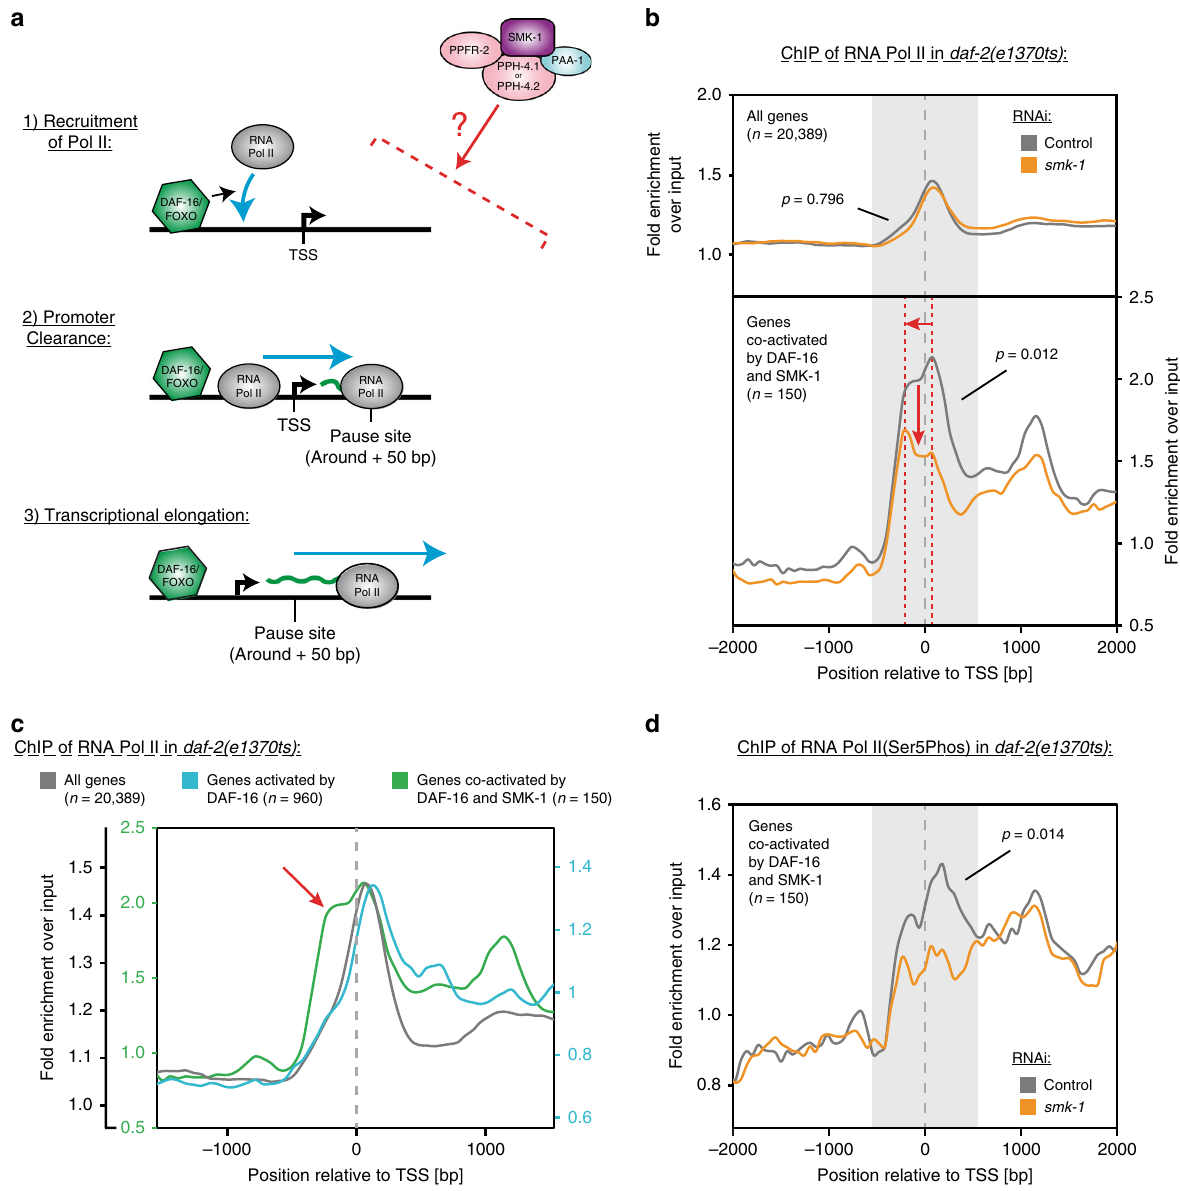
Fig. 5 PP4 SMK-1 is required for transcription initiating events at the genes co-activated by DAF-16 and SMK-1. a Schematic of the key steps that lead from DAF-16 ’ s binding to promoter regions to the eventual transcription of the downstream genes. b – d ChIP-seq analysis of RNA Pol II under low IIS. daf-2 (e1370ts) mutant animals were synchronized and grown from the L1 stage on either control or smk-1 RNAi bacteria. At the L4 stage, animals were shifted to 25 °C. After an additional 16 h, animals were harvested and ChIP-seq analysis was conducted, using antibodies recognizing RNA Pol II, either in any modi fi cation state ( b , c ) or speci fi cally RNA Pol II that was phosphorylated at Ser5 of its CTD ( d ). Average read densities across TSS regions of the indicated gene sets are shown. p values indicate the signi fi cance of read density differences in the grayed regions ( − 600 to + 600 around the TSSs) between control and smk-1 RNAi treated animals. Source data underlying Fig. 5b, d are provided as a Source Data fi